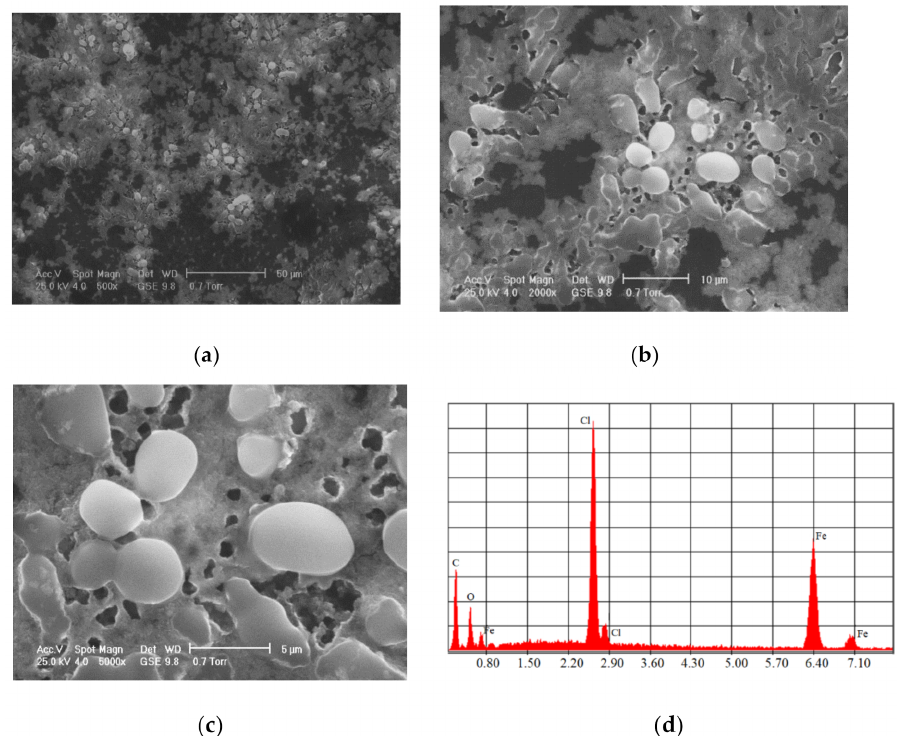
Figure 2. SEM analysis made in the case of Fe 3 O 4 MNPs obtained through the co-precipitation method at three different magnification scales: ( a ) 500 × ; ( b ) 200 × ; ( c ) 5000 × ; and the resulting elemental analysis ( d